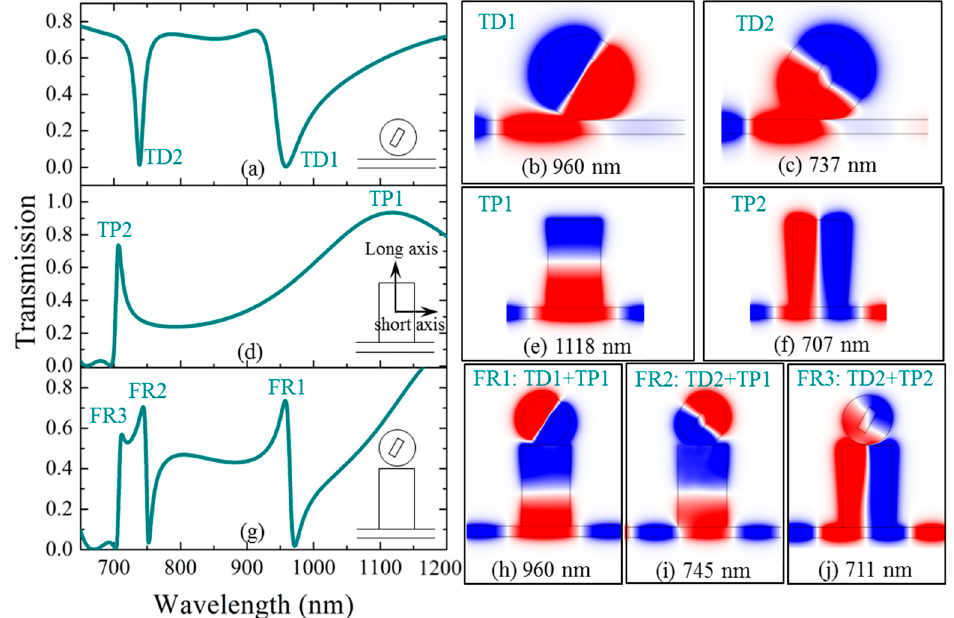
Figure 2. ( a ) The transmission of a metal-strip-core cavity coupled with a waveguide. The H z magnetic field distributions of the transmission dips at ( b ) TD1, λ = 960 nm; ( c ) TD2, λ = 737 nm. ( d ) The transmission of a rectangular cavity connected with a waveguide. The H z magnetic field distributions of the transmission peaks at ( e ) TP1, λ = 1118 nm; ( f ) TP2, λ = 707 nm. ( g ) The transmission of a coupled system consisting of a waveguide, a rectangular cavity, and a metal-strip-core circular cavity. The H z magnetic field distributions of the Fano peaks at ( h ) FR1, λ = 960 nm; ( i ) FR2, λ = 745 nm; ( j ) FR3, λ = 711 nm.